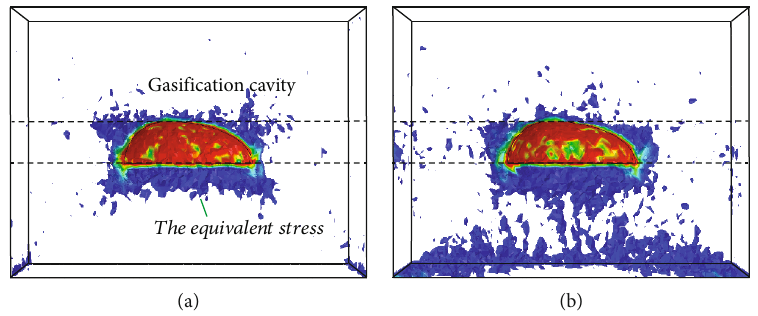
Figure 4: The variation pattern of the equivalent stress in the combustion cavity: (a) condition 1 and (b) condition 2.